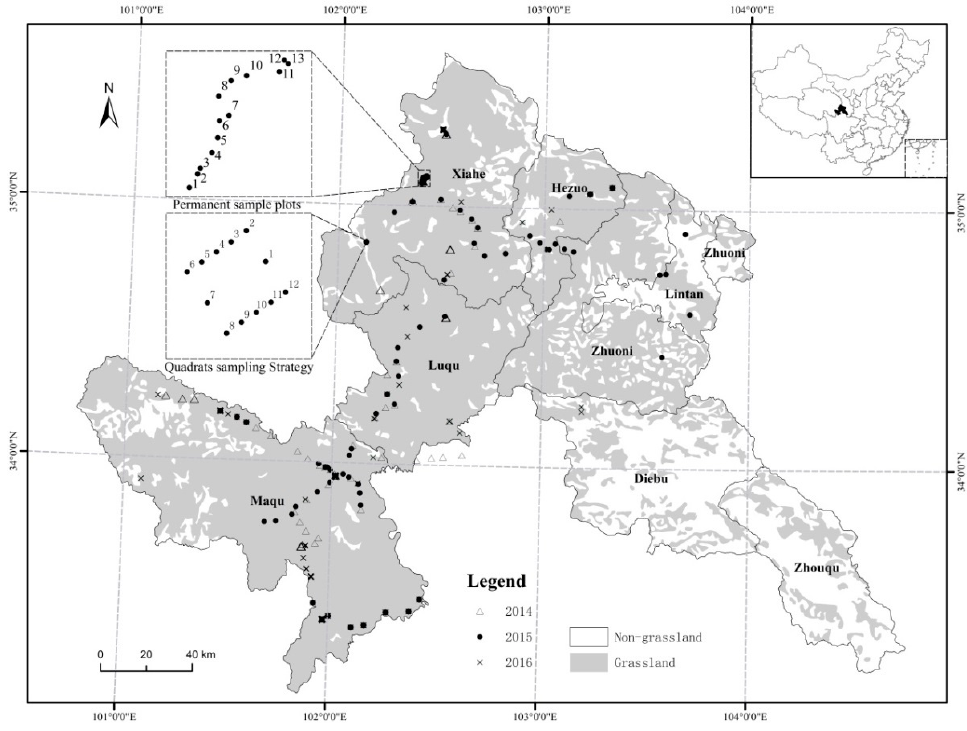
Figure 1. Location of the observation sites in the pastoral area of Gannan Prefecture, China.